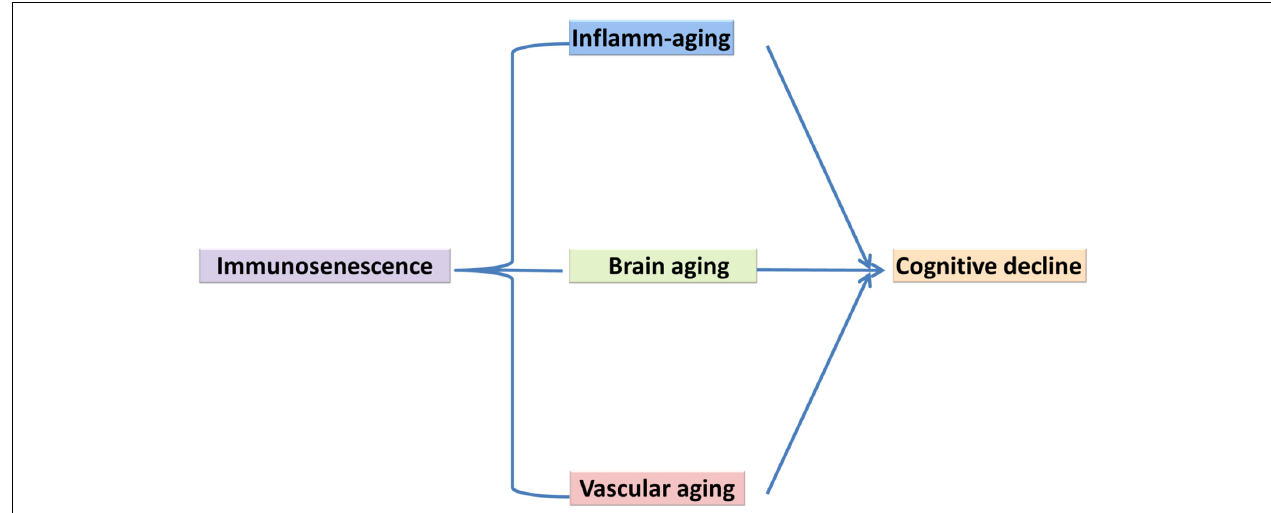
FIGURE 2 | Immunosenescence is a key mechanism underlying cognitive